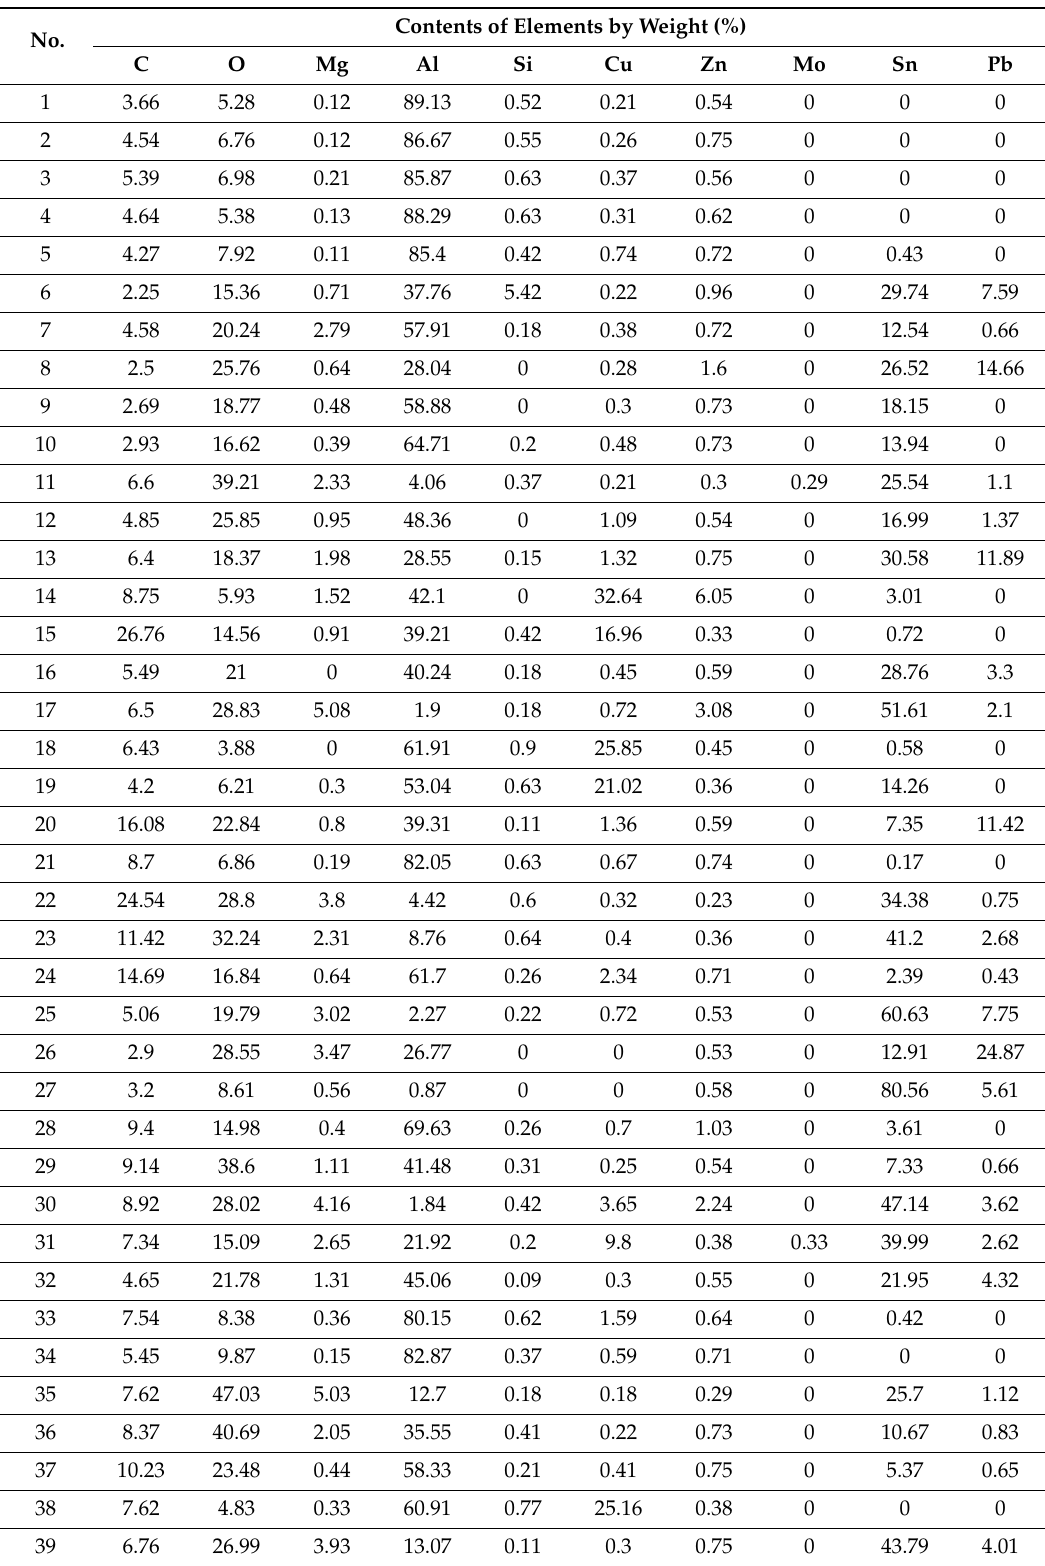
Table 3. Energy-dispersive X-ray spectroscopy (EDS) chemical identification of elements and their concentration in M1